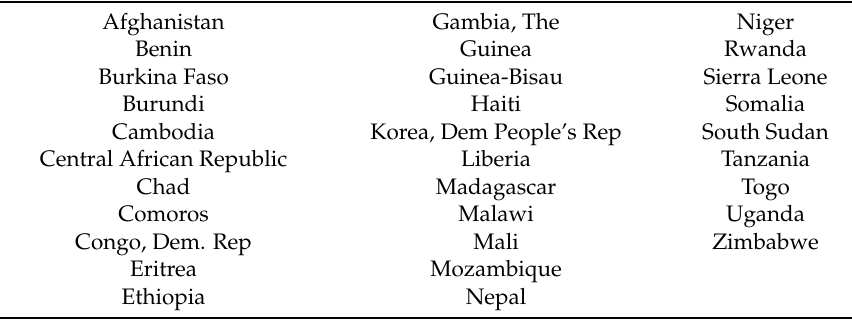
Table A1. List of low income economies ($1045 or less).